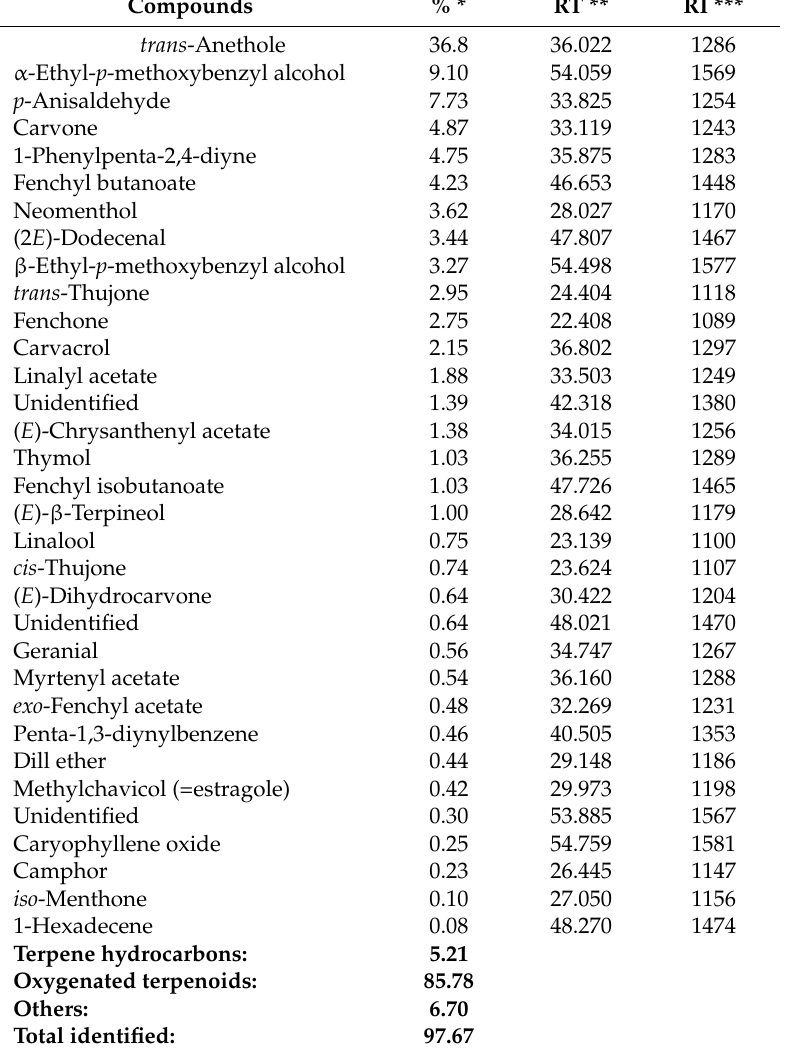
Table 1. Chemical composition of the essential oil of Foeniculum vulgare according to a GLC-MS analysis.